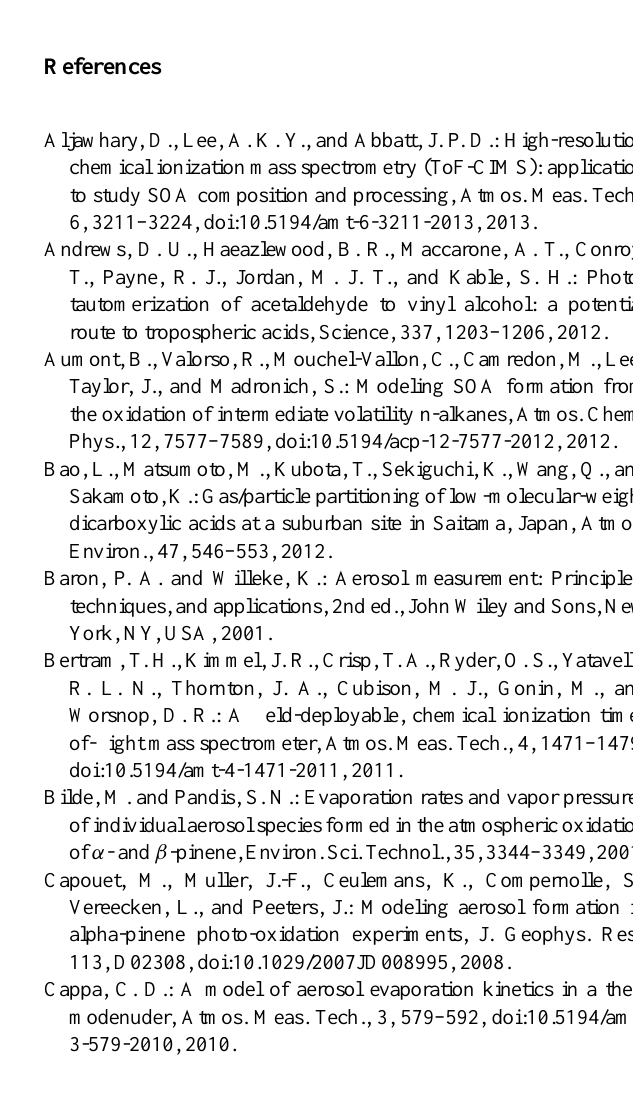
Fig. 15. Time series of F p for six known terpenoic acids (including isomers) measured on 26 August 2011. Also shown are model results of F p . The pinonic acid model result is multiplied by a factor of 20 to allow comparison of relative trend with the data and is shown in the same